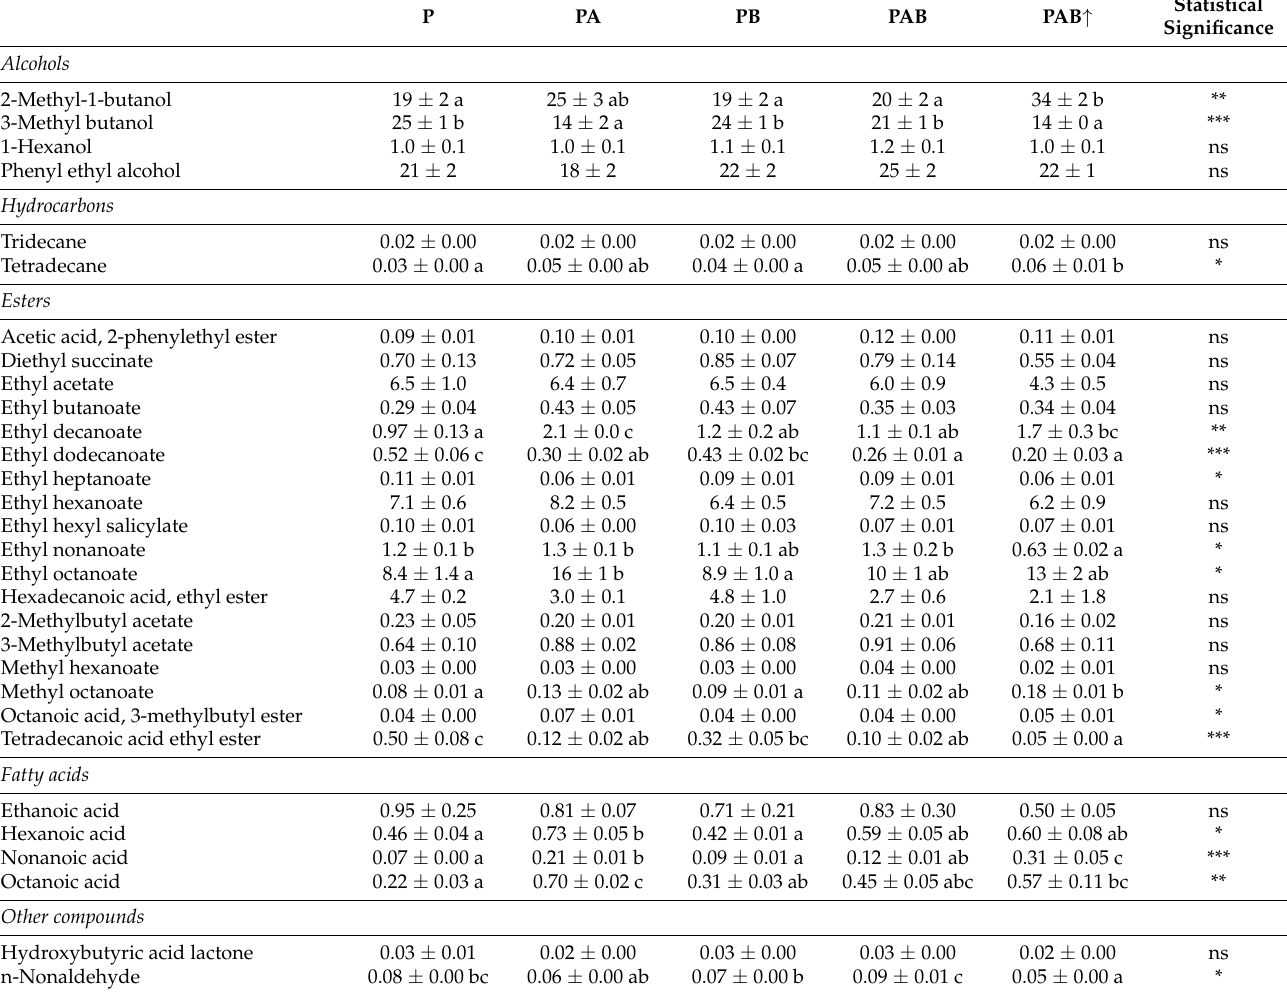
Table 2. Relative abundance (percentages) of individual volatile organic compounds (VOCs) in wines made from grapes exposed to five different radiation regimes: P (only PAR), PA (PAR + UV-A), PB (PAR + UV-B), PAB (PAR + UV-A + UV-B), and PAB ↑ (PAR + UV-A + enhanced UV-B). For each compound, the statistical significance of a one-way ANOVA test using the radiation regime as the main factor is shown, and different letters indicate significant differences between radiation regimes (Tukey test). Means ± SE are shown. *** p < 0.001; ** p < 0.01; * p < 0.05; ns, not